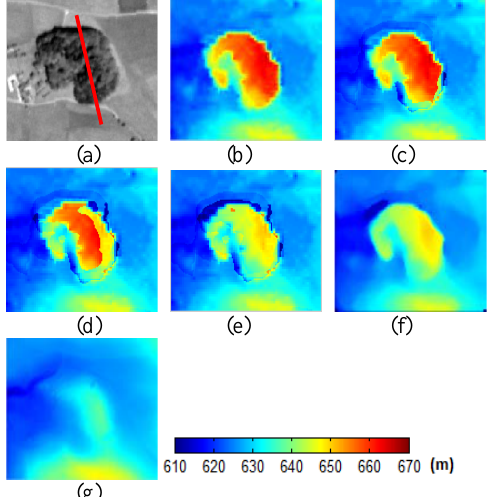
Figure 5. DTM generation procedure of the forest example (a) panchromatic images ; (b) original DSM; (c) DTM1; (d) DTM2; (e)DTM3; (f) Refined DTM; (g) reference DTM.